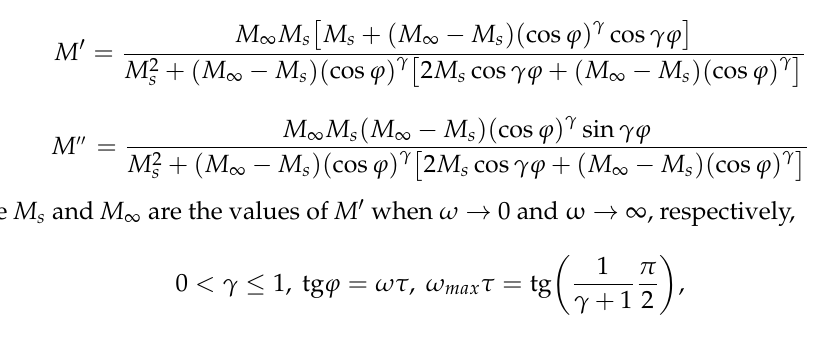
a mixture with 20 wt.% AgNO 3 and 15 wt.% PI at various temperatures of measurements. The solid lines represent ap-